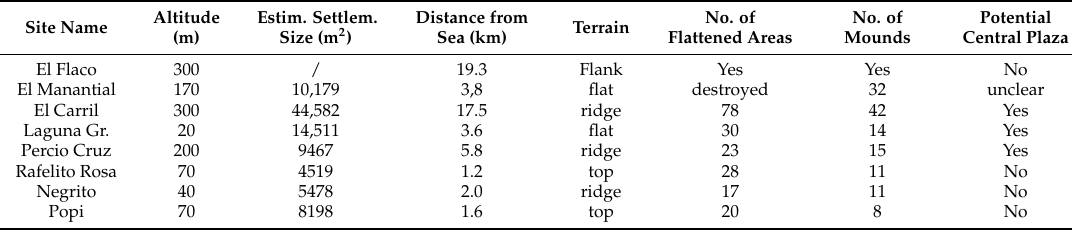
Table 3. Comparison of sites. So far, for El Flaco, comparable parameters have not been available due to the thick vegetation surrounding the site. Deep ploughing has severely altered the topography at El Manantial.